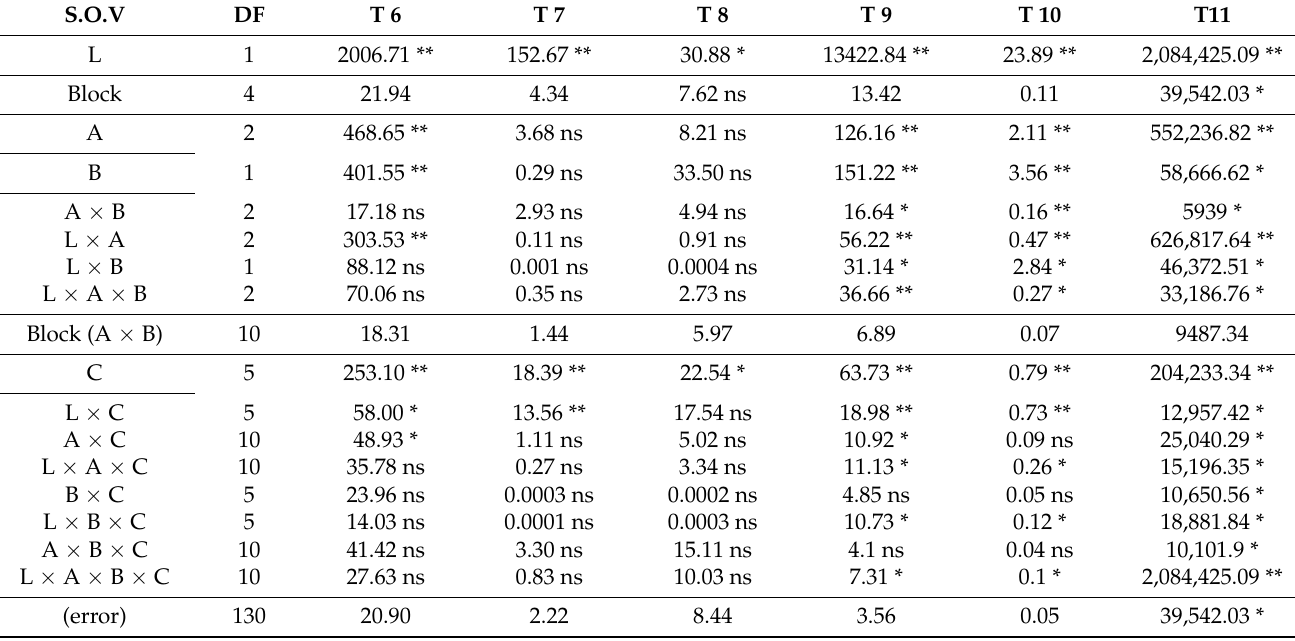
Table 4. Analysis of variance of evaluated quantitative and qualitative traits. T 6: Root length (cm); T 7: Root dry matter digestibility (%); T 8: Root crude protein (%); T 9: Sodium content (mg/100 g.sugar); T 10: Catalase content (u/mg.pr); T 11: Sugar content (mg/g DM); A: Methanol concentration; B: Glycine betaine concentration; C: Genotypes; L: Location; ns non-significant, * significant at 0.05, ** significant at 0.001.